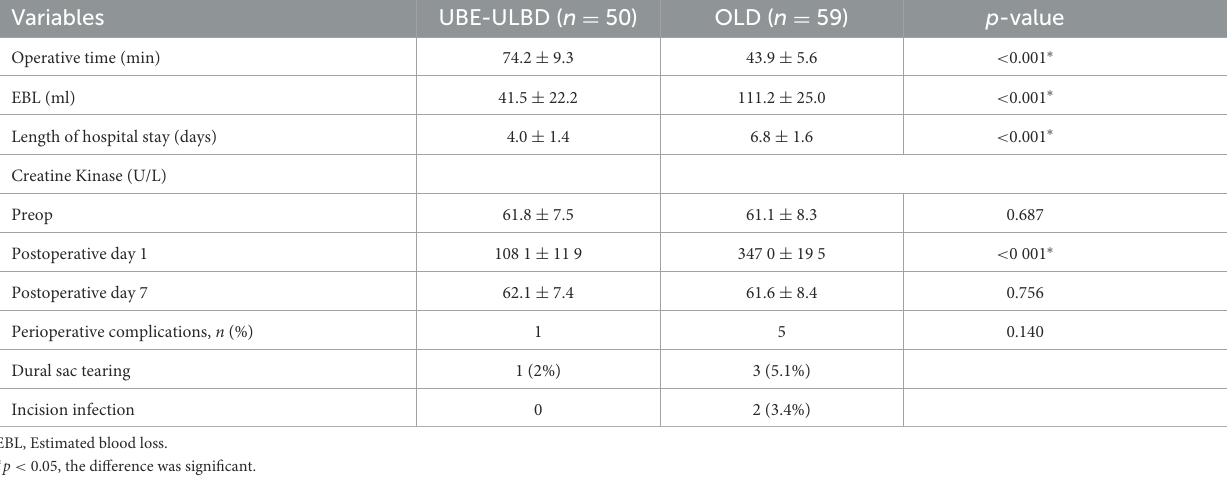
TABLE 3 Radiographic outcomes by type of procedure at 1-year